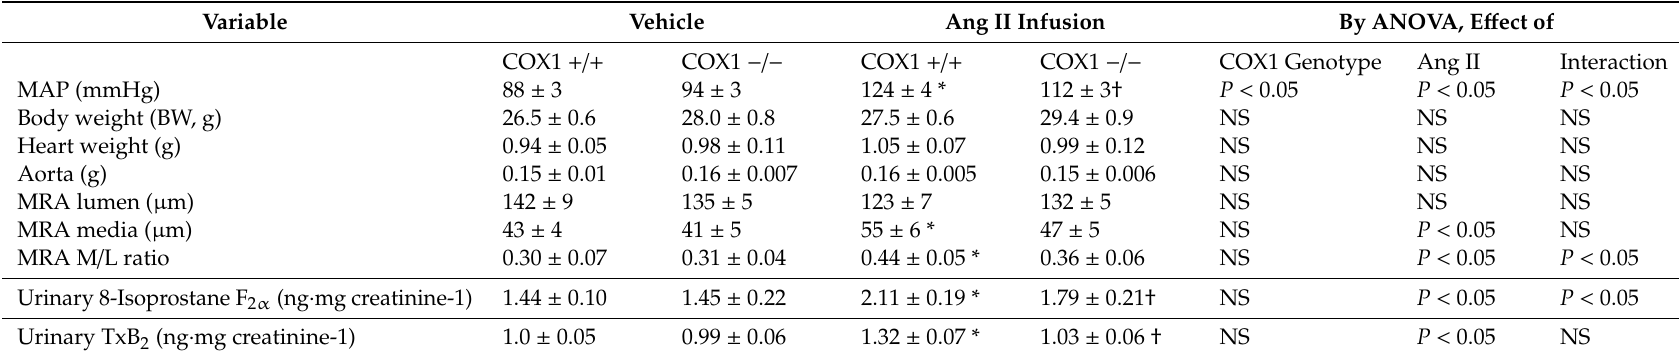
Table 2. Basal parameters in conscious mice for mean arterial pressure, body, heart, and aorta weights, mesenteric resistance vessel (MRA) remodeling, and urinary biomarkers in cyclooxygenase (COX) 1 +/+ and − / − mice infused with angiotensin II (Ang II) or